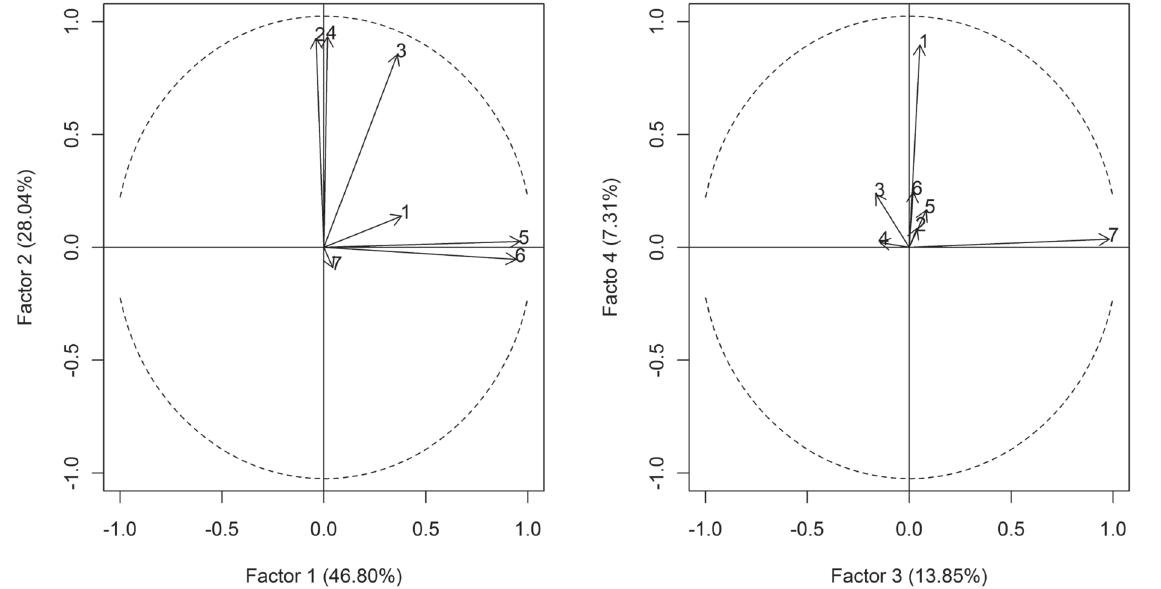
Fig. 3. Factors pattern after varimax rotation. Following are the symbol descriptions: 1: temperature stability, 2: rain- fall, 3: discharge, 4: sediment load, 5: surface area of drainage basin, 6: weighted latitude, 7: water